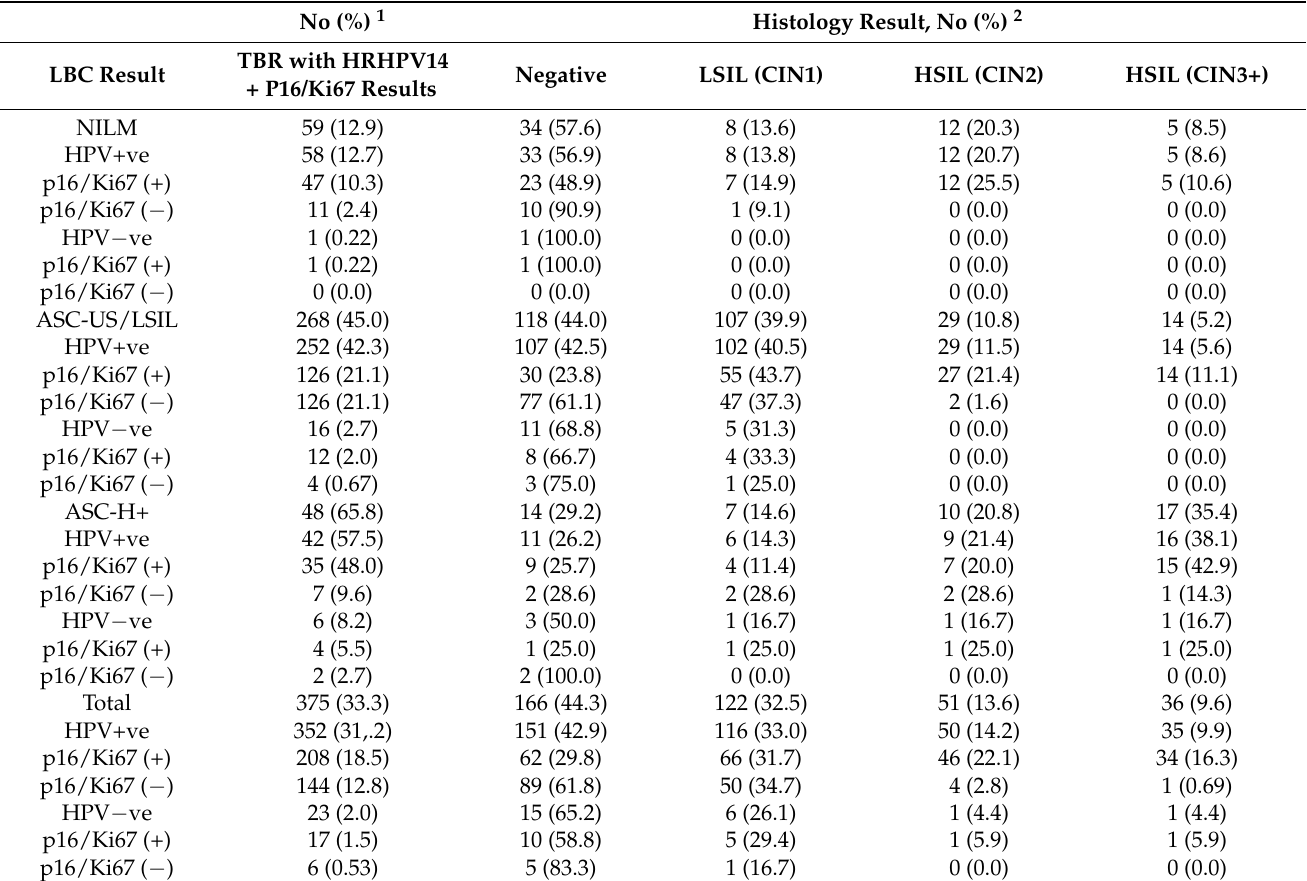
Table 9. The histologic correlation for LBC, HRHPV14, and p16/Ki67 results